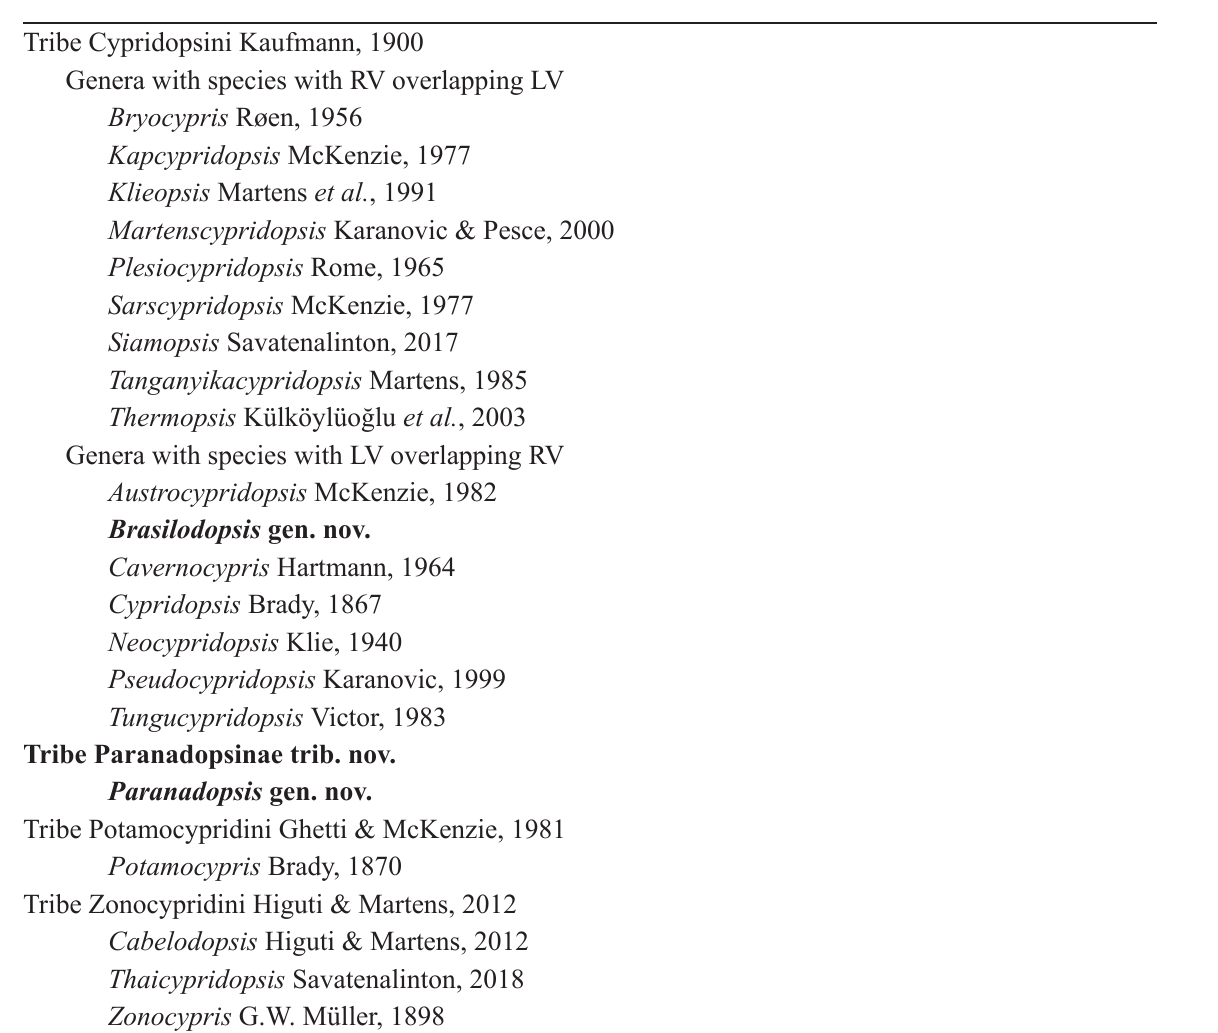
Table 1. Present list of tribes and genera in the subfamily Cypridopsinae Kaufmann, 1900. New tribe and new genera here described are in